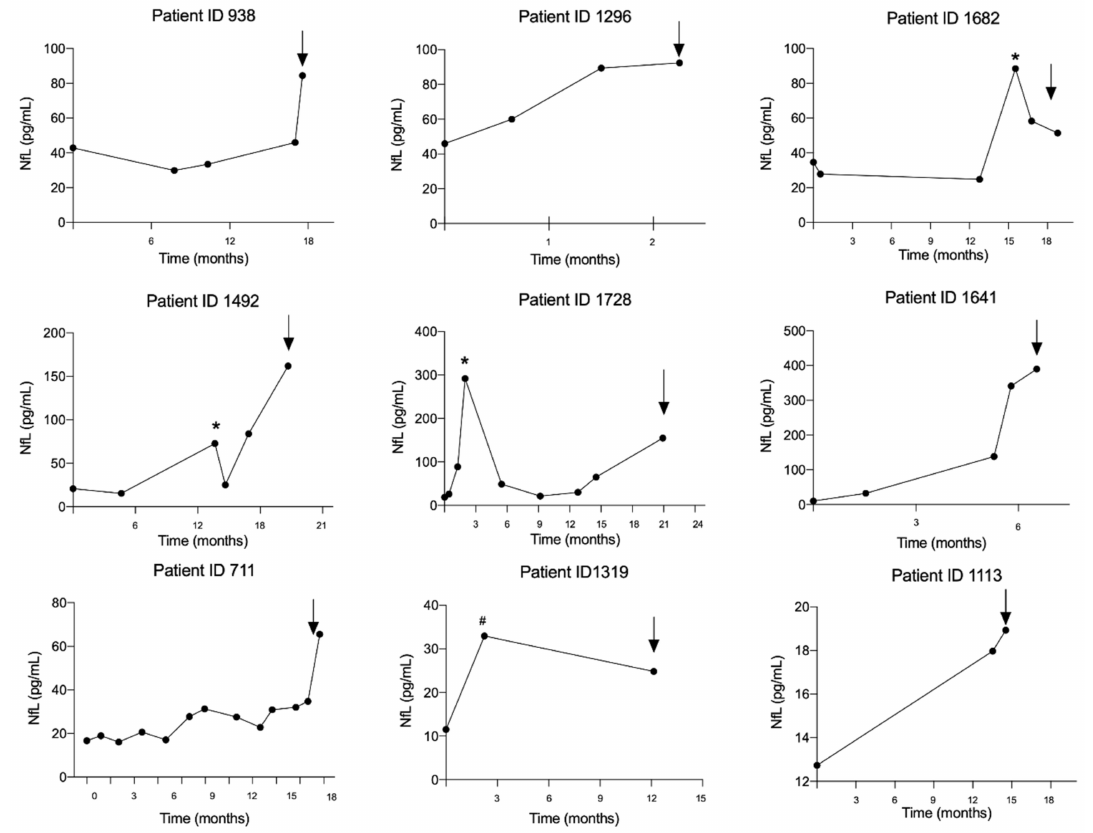
Figure 3. The trajectories of the neurofilament light chain level from time of lung cancer diagnosis to the time of brain metastasis in nine lung cancer patients. The arrows indicate time of brain metastasis diagnosis. The asterisks (*) marks the time point where the patient has received both chemotherapy and thoracic radiation against their lung tumor and the hashtag (#) marks the time point where the patient has received only chemotherapy. Abbreviation: NfL: Neurofilament light